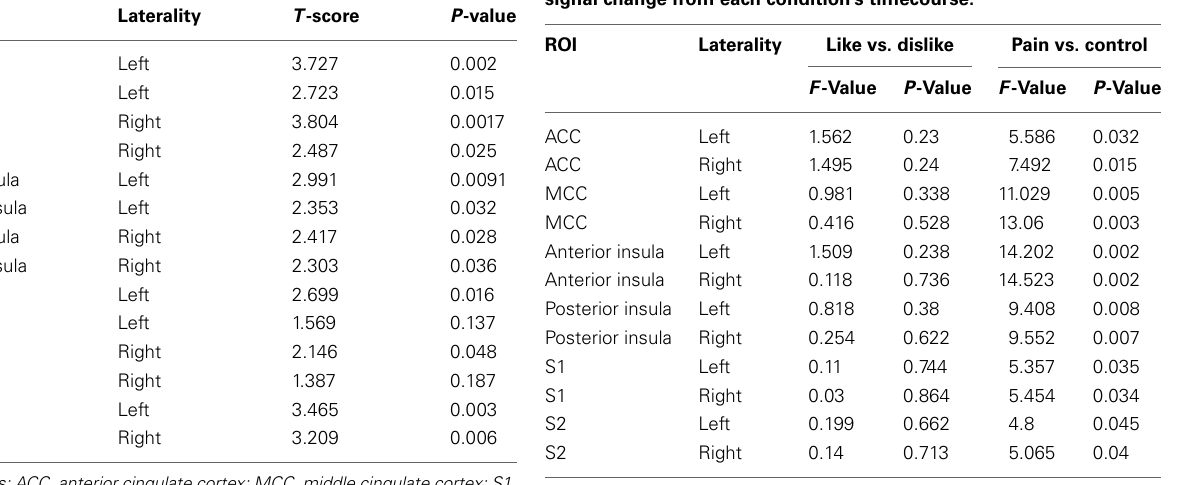
Table 2 | Event related averaging results from ANOVA comparisons among conditions for each hand drawn ROI using the peak percent signal change from each condition’s timecourse.